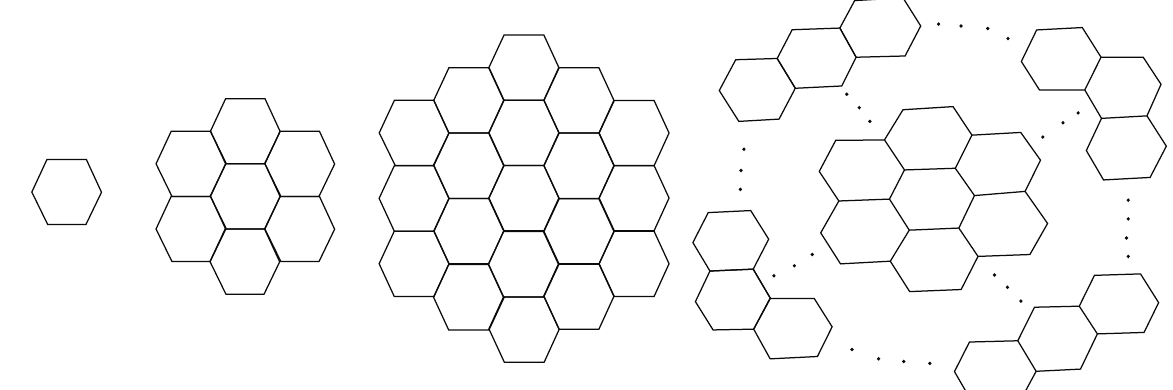
Figure 2: Circumcoronene series of benzenoid ( H